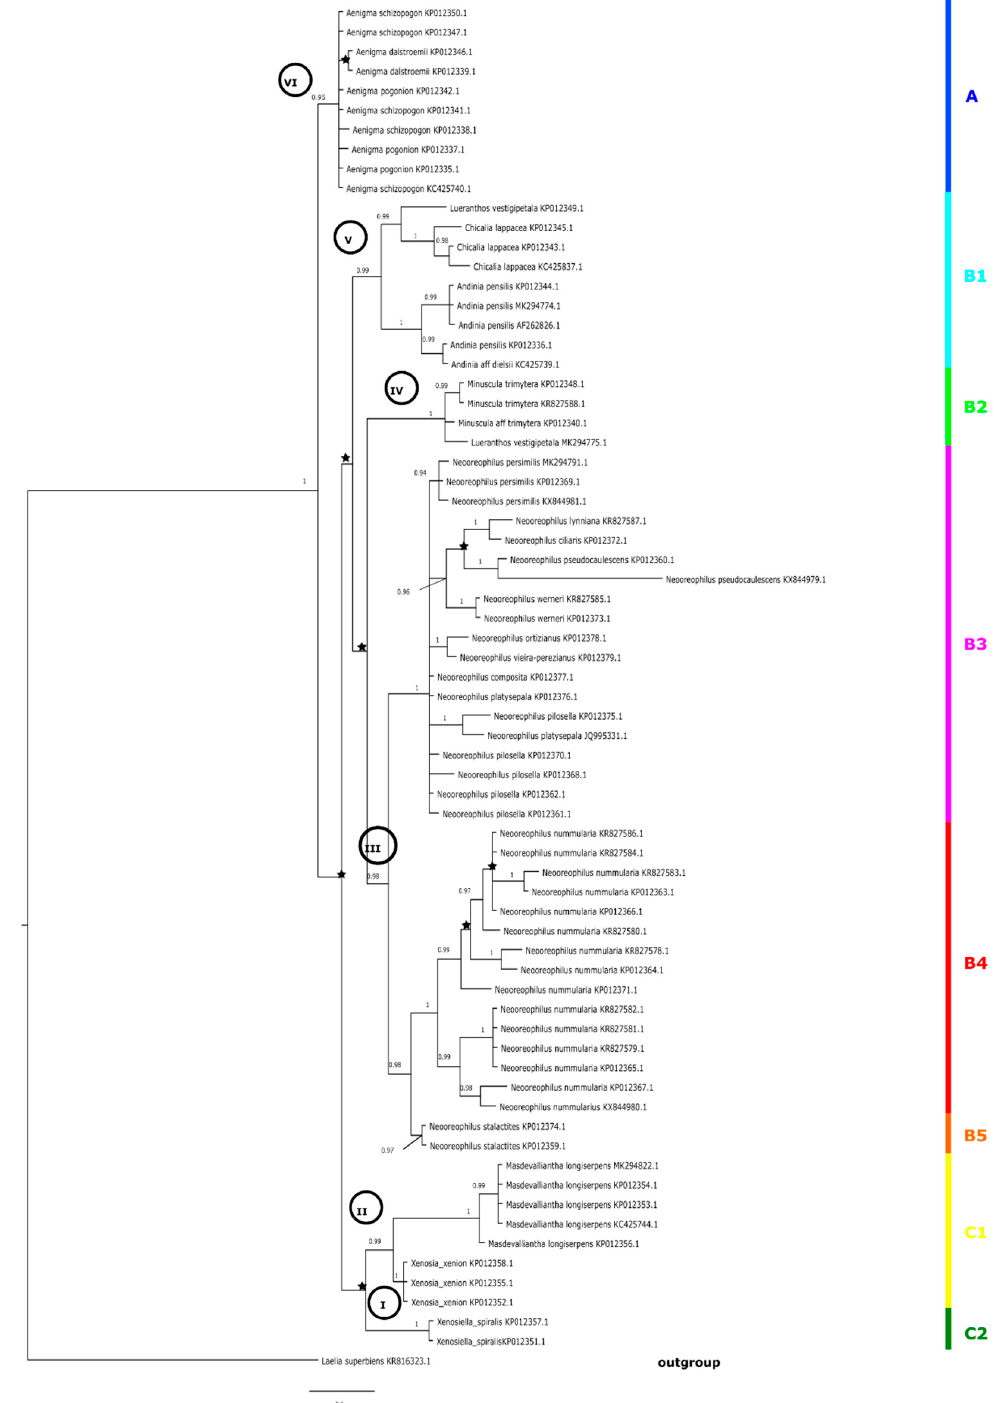
Figure 2. Majority-rule consensus tree for Andinia s.l. obtained in Bayesian analysis from ITS1-5.8S- ITS2 sequences. Values above branches represent posteriori probabilities; values with pp < 0.9 are indicated with an asterisk. The main and strong supported clades on the tree are marked with the numbers I–VI. Discussed groups of species are marked as A–C2.